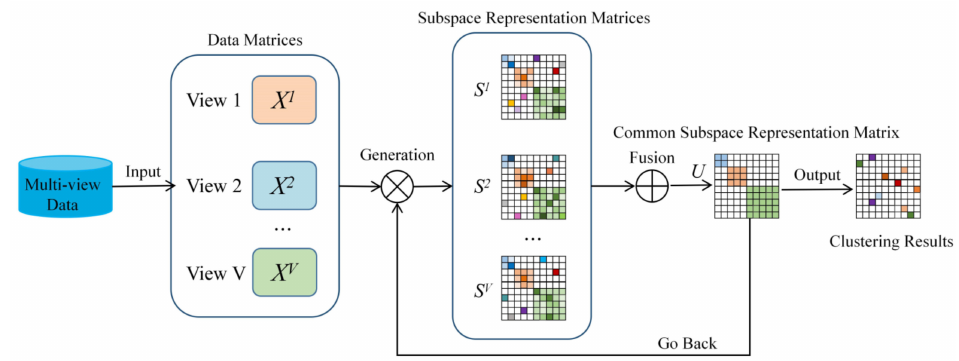
Figure 1. Framework of proposed